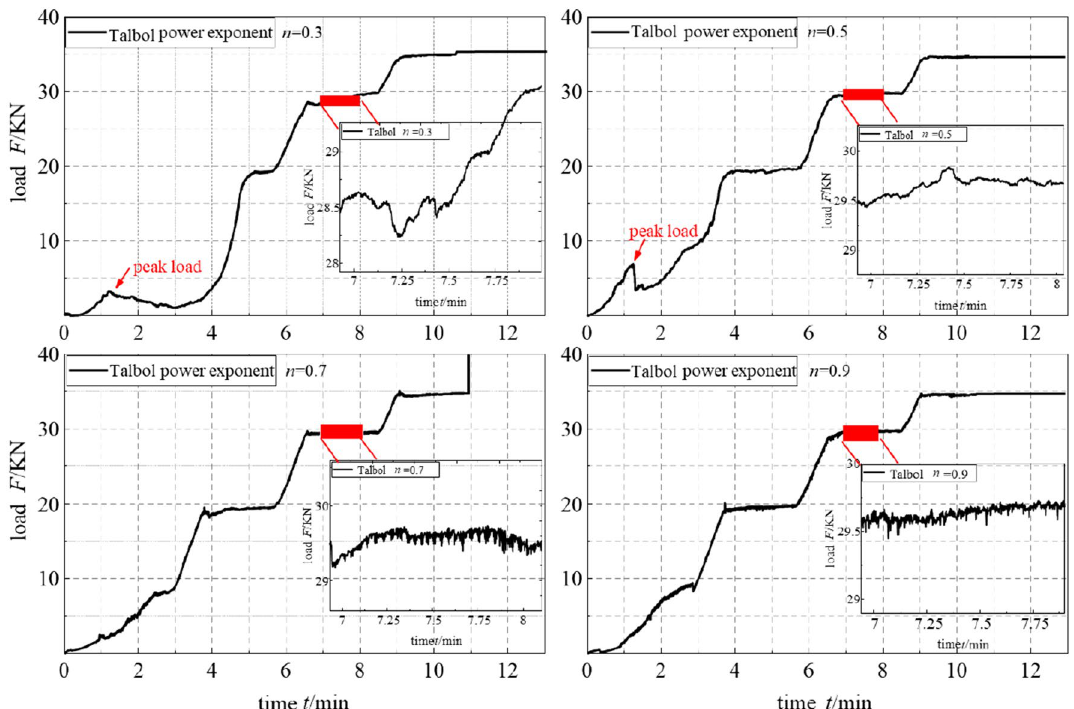
Figure 3. Relationship between the sample time and load in sample